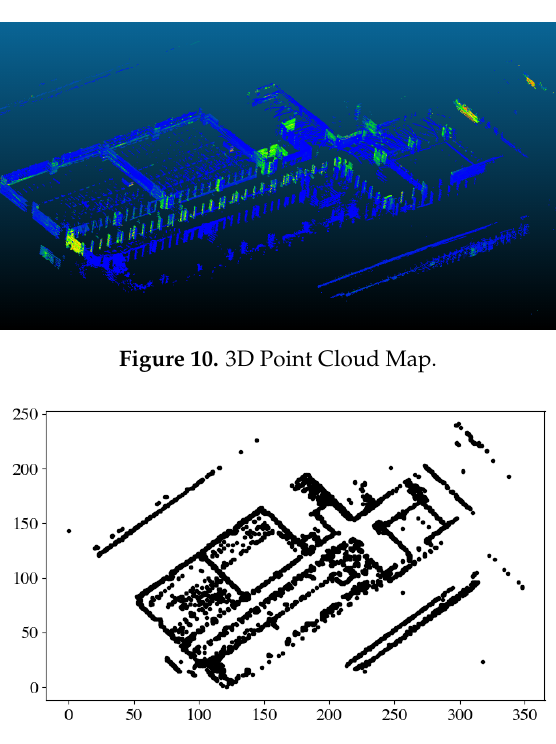
Figure 11. Point cloud map centered to 2D grid cells.